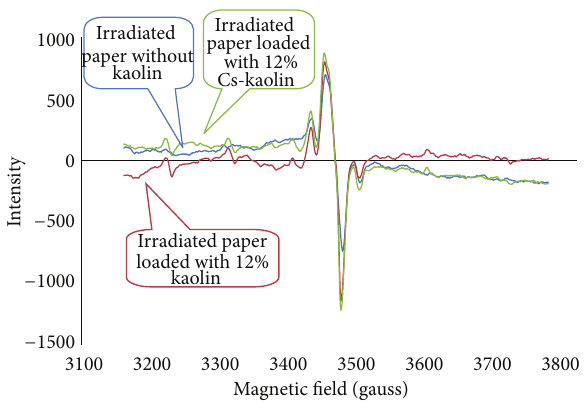
Figure 7: ESR spectra for irradiated wood paper handsheets (without kaolin, 12% kaolin, and 12% Cs-kaolin).